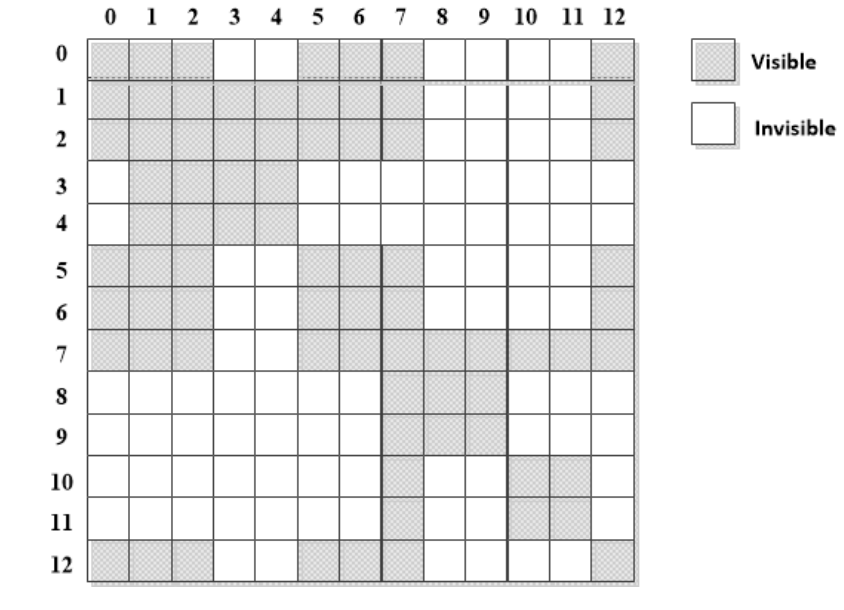
Figure 3. VM matrix.